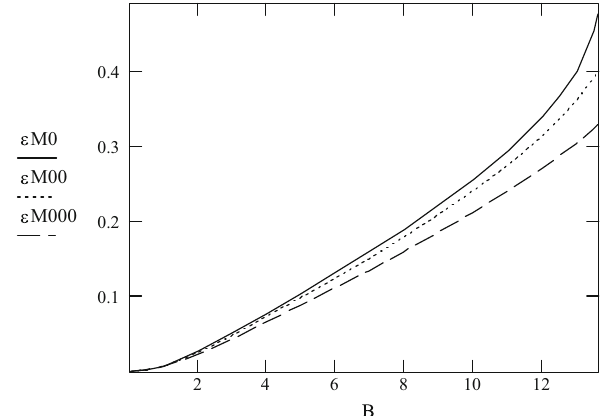
Fig. 4 The solid, dashed, dot curves of the relations between ε M 0 and B = l p β for ψ 0 = 0 . 01 , 0 . 02 , 0 . 03, respectively, while α l p = 1 for